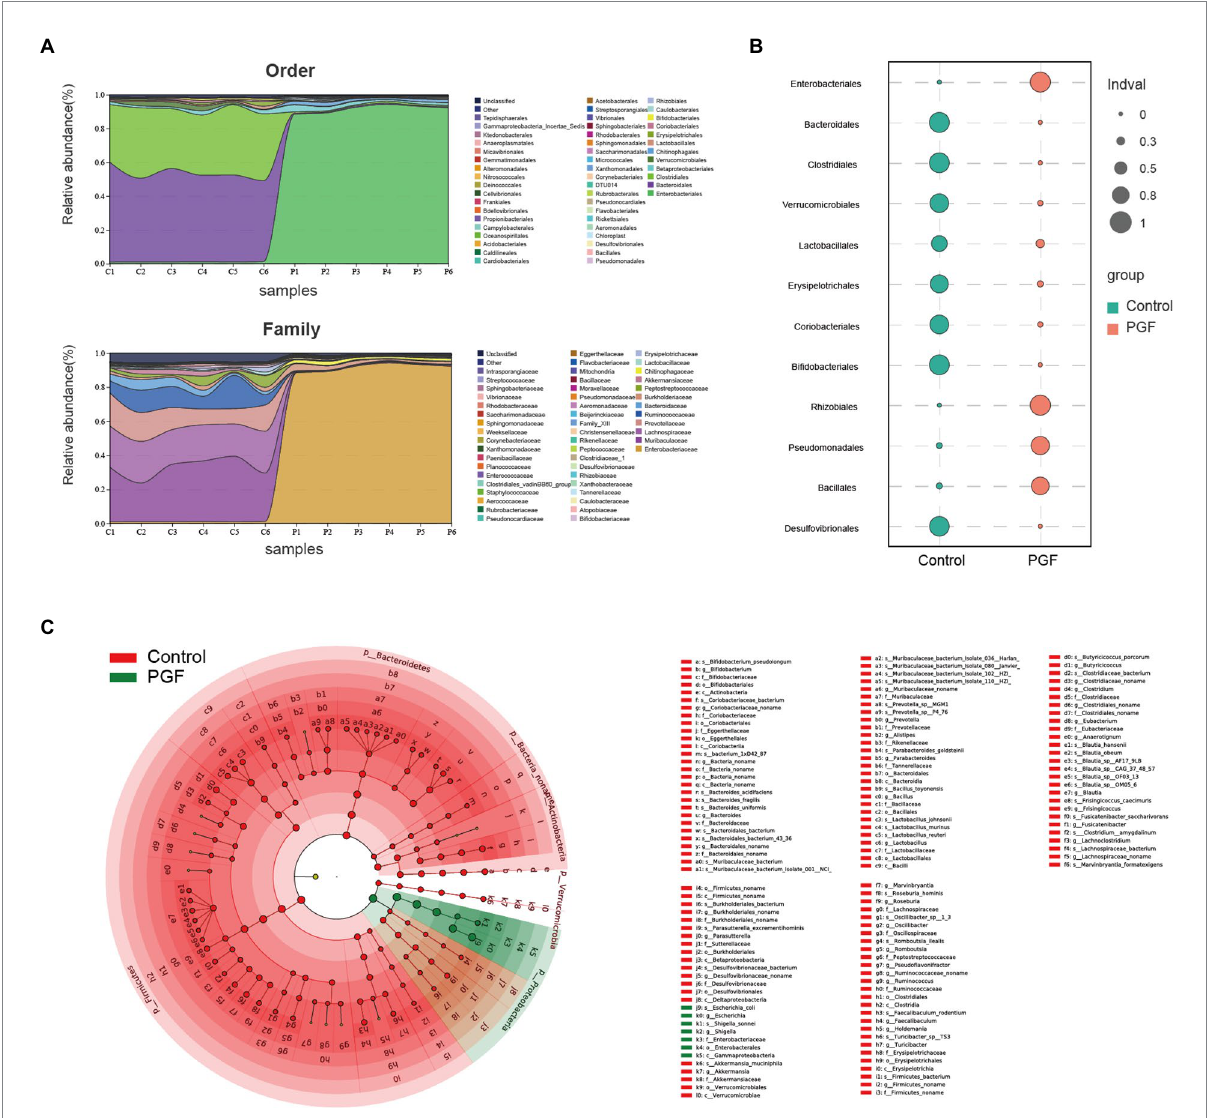
FIGURE 7 Microbiota characteristics of the feces from the control and PGF groups. (A) Distribution of bacterial orders and families ( n = 6); (B) Indicator taxa at order level based on the specie abundance and frequency of occurrence in two groups ( n = 6); (C) Different species based on the Linear discriminant analysis Effect Size (LEfSe) analysis, linear discriminant analysis (LDA) score > 2 and p < 0.05 ( n =